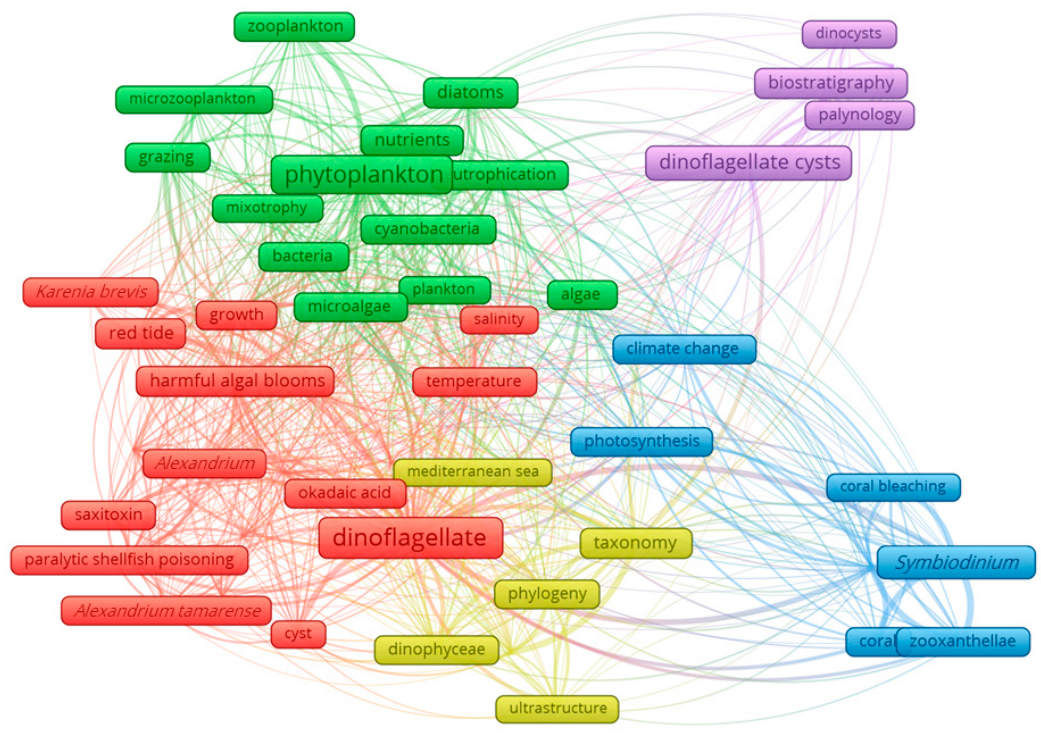
Figure 4. Keywords communities and their associations regarding dinoflagellate research.